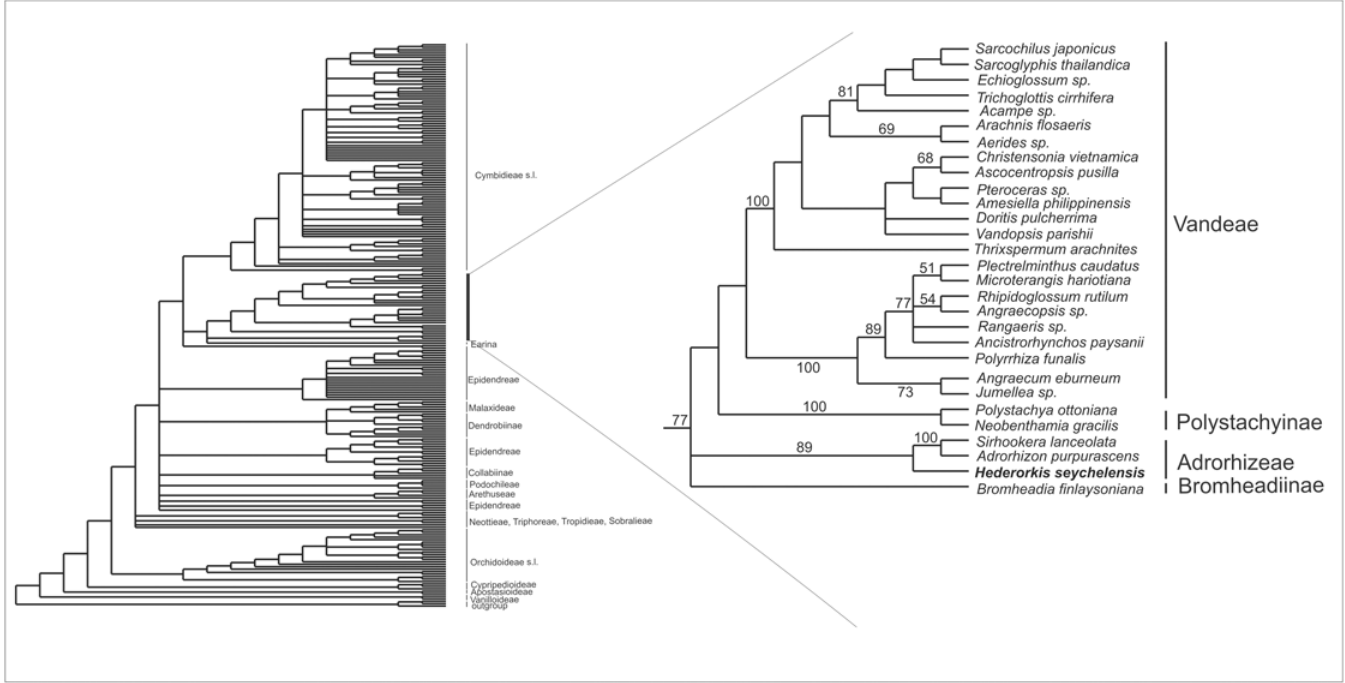
Fig 1. The strict consensus of 10.000 trees in mat K analysis (L = 4613, CI = 0.33 and RI = 0.68) for Orchidaceae. Bootstrap percentages > 50 are given for supported clades above branches. Subfamilies, tribes and subtribes (sensu Chase et al. (8) with exception of Vandeae, Polystachyinae and Adrorhizeae) are indicated where